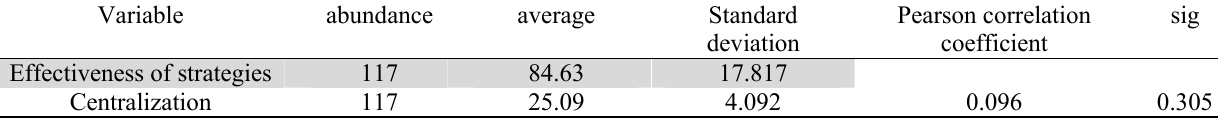
Pearson correlation sig deviation coefficient